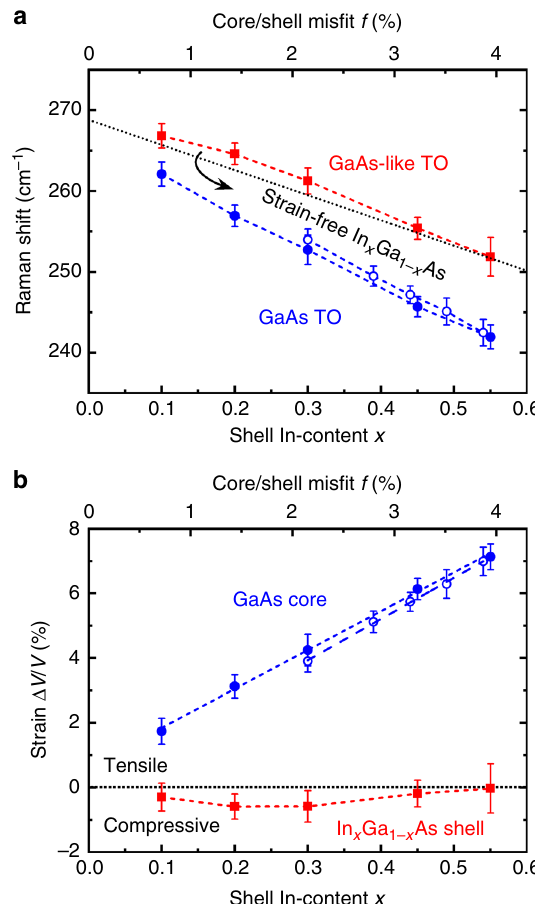
Fig. 4 Strain analysis of GaAs/In x Ga 1 − x As (shell thickness L S = 40 – 80 nm; closed symbols) and GaAs/In x Al 1 − x As ( L S = 80 nm; open symbols) core/ shell nanowires as a function of In-content x in the shell (bottom x -axis) and the corresponding core/shell mis fi t f (top x -axis). a Raman shift of the GaAs (blue data points) and the GaAs-like (red data points) transverse optical (TO) phonons as a function of x and f . The dashed lines are guides to the eye, whereas the dotted line shows the expected Raman shift of GaAs-like TO phonons in strain-free In x Ga 1 − x As. The error bars represent the standard deviation and the instrument error. GaAs-like TO phonons do not exist in In x Al 1 − x As shells. b The hydrostatic strain in the core (blue data points) and the shell (red data points) as a function of x and f . The blue dashed lines are linear fi ts, whereas the red one is a guide to the eye. The error bars originate from the error bars in Raman